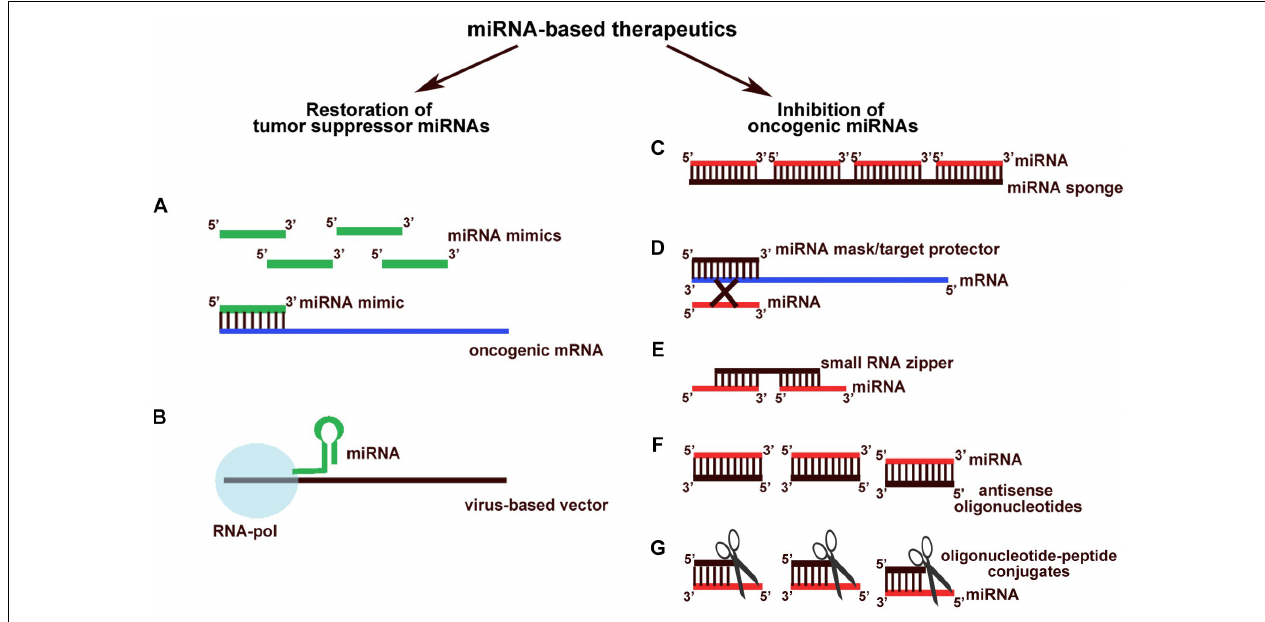
FIGURE 2 | Different oligonucleotide-based miRNA-targeted therapeutics. Constructions aimed at restoration of levels of tumor suppressor miRNAs: (A) synthetic miRNA mimics; (B) endogenously expressed tumor suppressor miRNAs from virus-based vectors. Therapeutics aimed at inhibition of oncogenic miRNAs: (C) miRNA sponges; (D) miRNA masks (target protectors); (E) small RNA zippers; (F) antisense oligonucleotides; (G) oligonucleotide-peptide conjugates